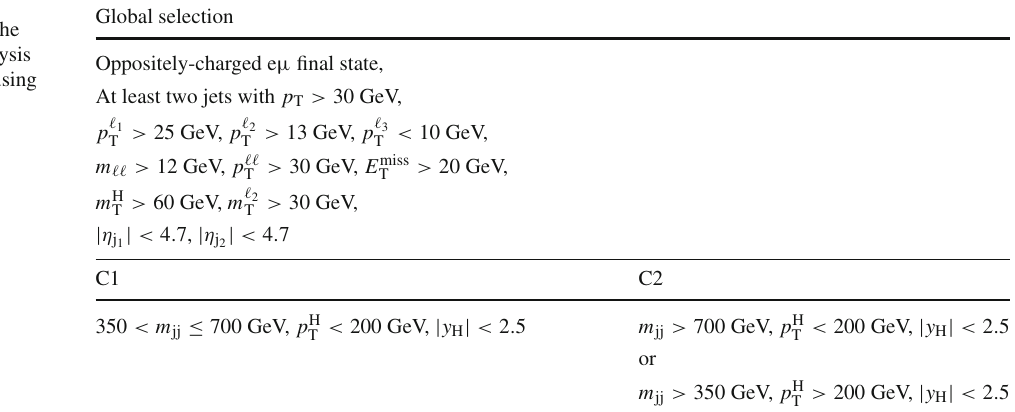
Table 1 Definition of the analysis phase space. All the variables used for the analysis requirements are defined using particle-level quantities